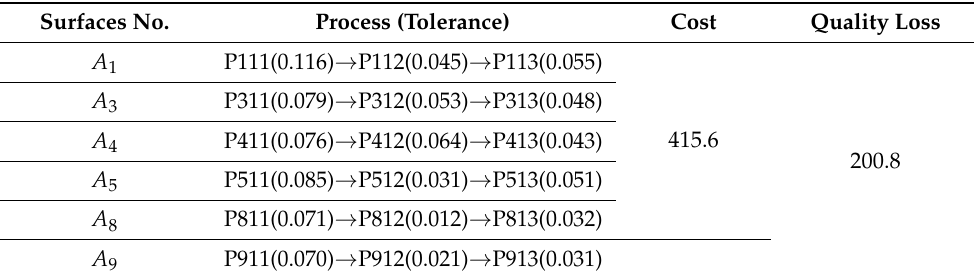
Table 10. Tolerance optimal scheme of a used